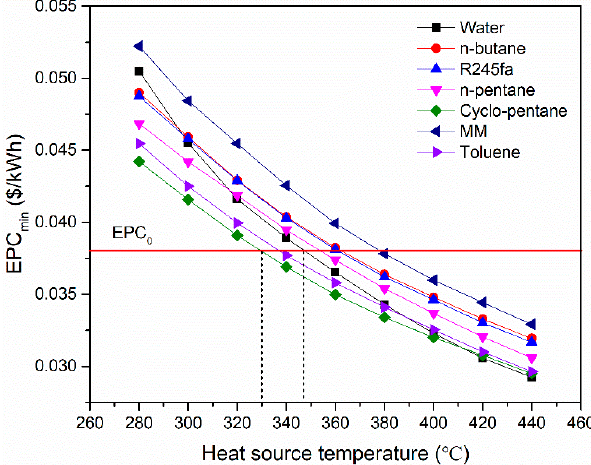
Figure 13. The minimum EPC s of the ORC and SRC systems under different heat source temperatures.